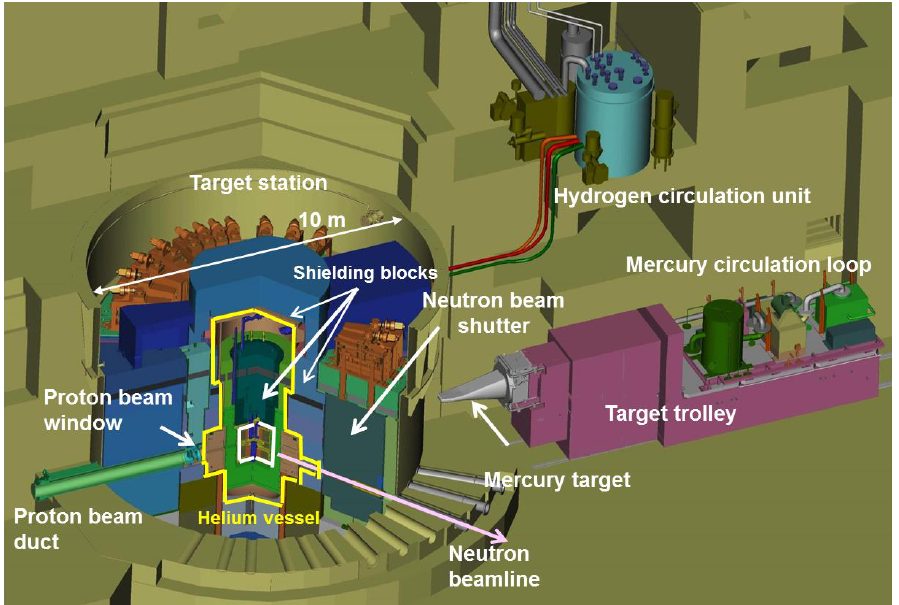
Figure 1. Cutaway view of the target station of pulsed spallation neutron source of the Japan Proton Accelerator Research Complex (J-PARC) with target trolley moved back to the service position.